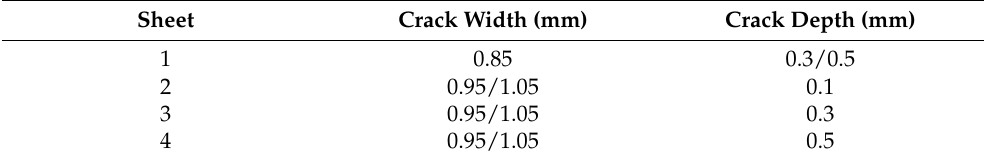
Table 2. Crack sizes on the Al sheets.